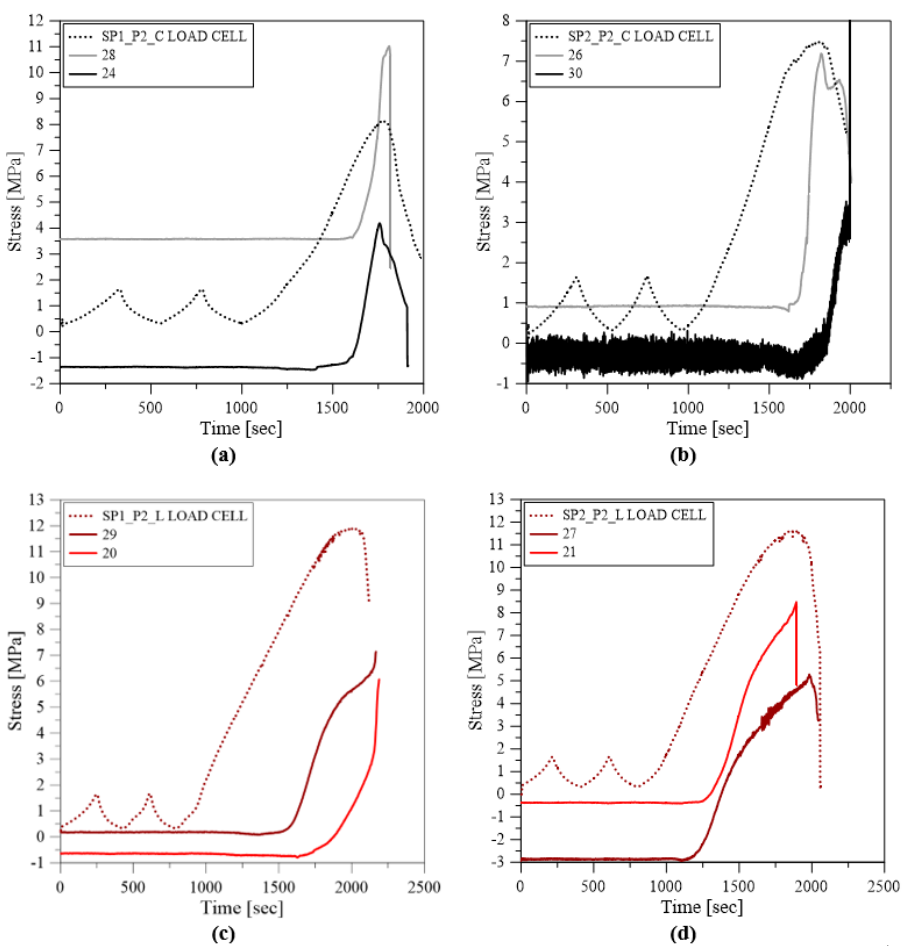
Figure 16. Comparison of outcomes from ceramic sensor and load cell, for post-installation system P2: ( a , b ) calcarenite masonry; ( c , d ) clay brick masonry.